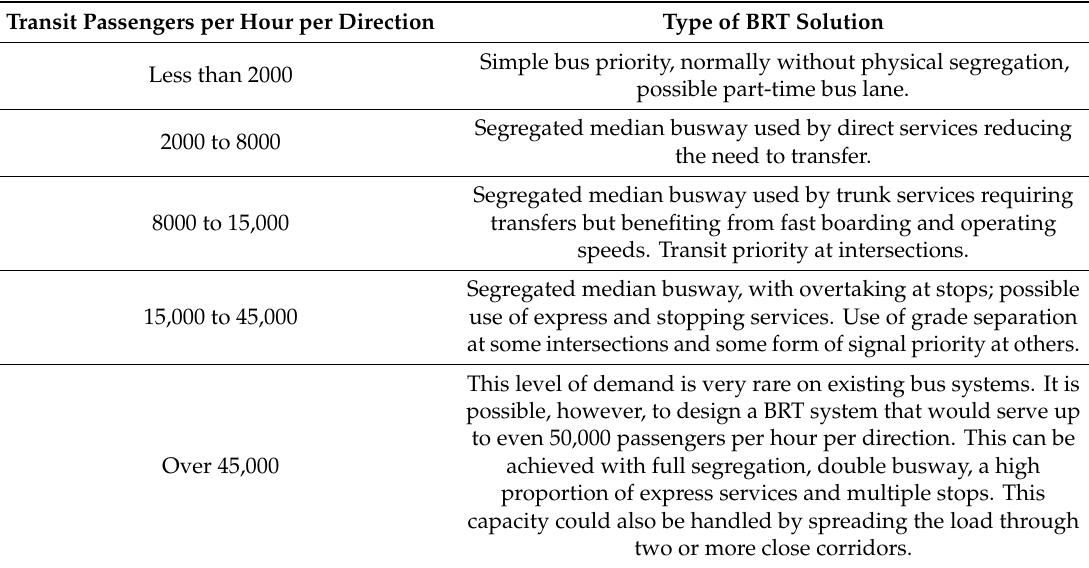
Table 3. Typical BRT configuration according to demand